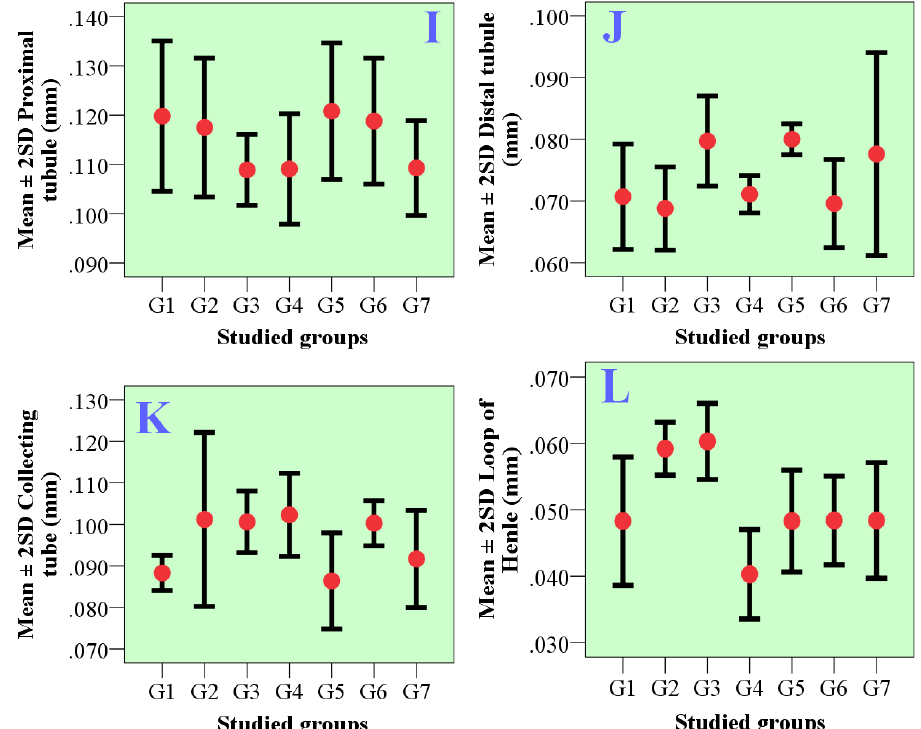
Fig. 5. The proximal tubule (I), Distal tubule (J), Collecting tube (K), and Loop of Henle (L) between different studied